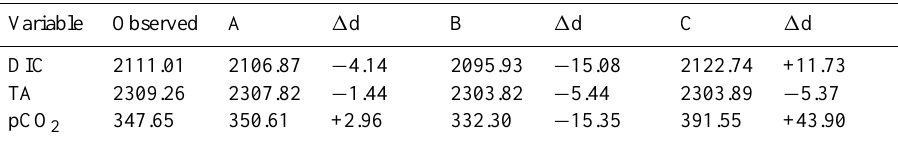
Fig. 8. Time series of model versus satellite-derived Chl a, PIC (b) , and PP (c) . The black lines are the daily model parameters. The black dots in (a) and (b) are monthly SeaWiFS standard products, while the black dots in (c) are monthly satellite-derived CbPM PP values. The blue line time series in panel (b) is the model-derived euphotic depth to mixed layer thickness ratio (Zeu/MLD), and the two green triangles are PP values from in situ C-14 incubations. Note that the y-scales for Chl and PP are logarithmic. Table 1. Tabulated values show comparisons between observed and modeled mean DIC, TA, 1026 and surface ocean p CO 2 . Values are for the reference (Experiment A), no relaxation (Experiment B), and abiotic (Experiment C) runs. Only daily model values matching the nearest observed dates were included. Differences between model experiments and observed values ( 1 d) are also included. The time periods for averaging are 1991–2007 for DIC, 1997–2007 for TA, and 1993–2007 for